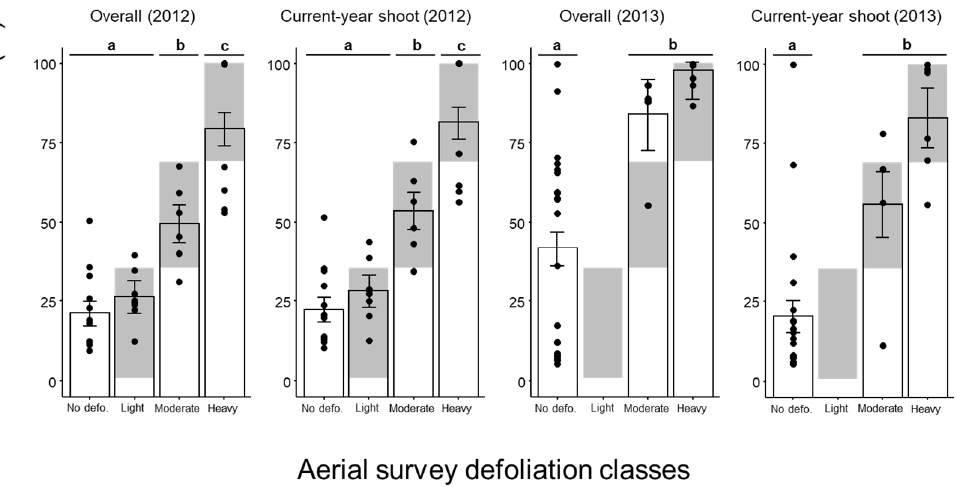
Figure 5. Validation of the aerial survey defoliation classes using the overall or current-year shoot defoliation estimated with the field Fettes method after the first (2012) and second (2013) year of the hemlock looper outbreak. Different letters highlight significant differences in the defoliation estimated between the ground and the aerial defoliation classes after Tukey’s pairwise comparisons. Dots represent the plot mean defoliation, and error bars represent the standard error of the mean for a given class. Gray areas represent the interval of percentage defoliation included in each MFFP class.